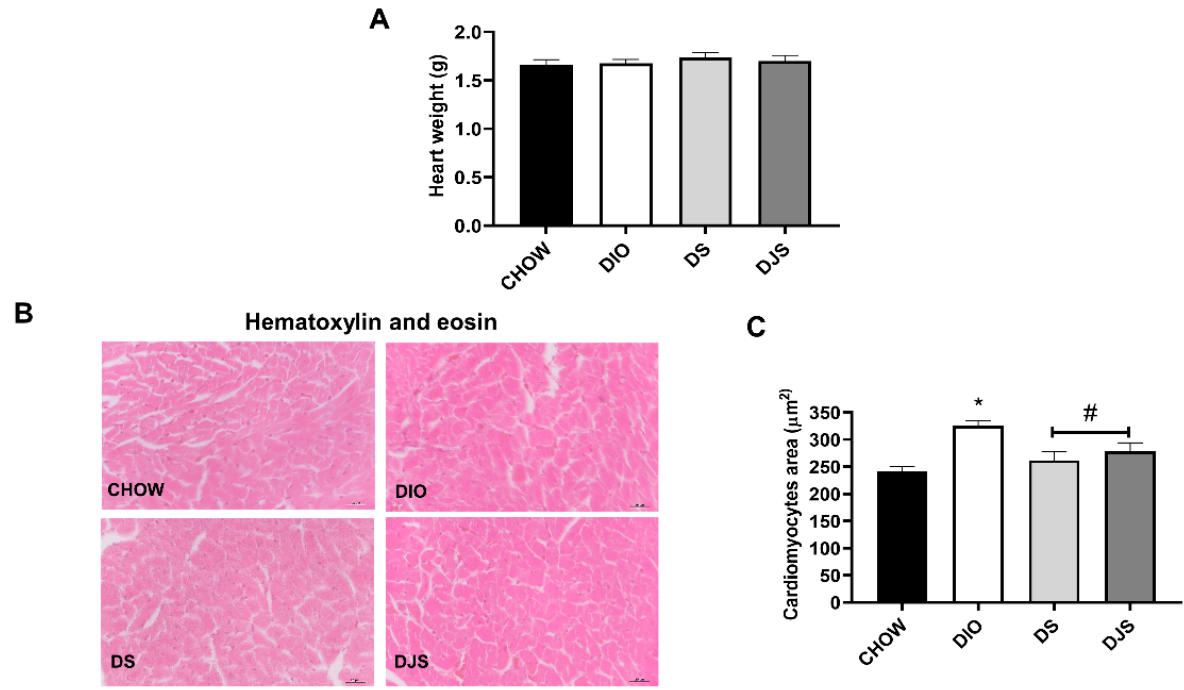
Figure 1. Heart weight and assessment of cardiomyocyte hypertrophy. ( A ) Whole heart weight; ( B , C ) Representative pictures of hematoxylin and eosin staining and quantification of cardiomyocyte cross-sectional area CHOW rats ( n = 8), fed with standard diet; DIO rats ( n = 9), fed with high-fat diet; DS ( n = 12), DIO rats supplemented with tart cherry seeds; DJS ( n = 9), DS rats supplemented with tart cherry juice. Magnification 40 × . Scale bar 25 µ m. Data are mean ± SEM. * p < 0.05 vs. CHOW rats; # p < 0.05 vs. DIO rats.